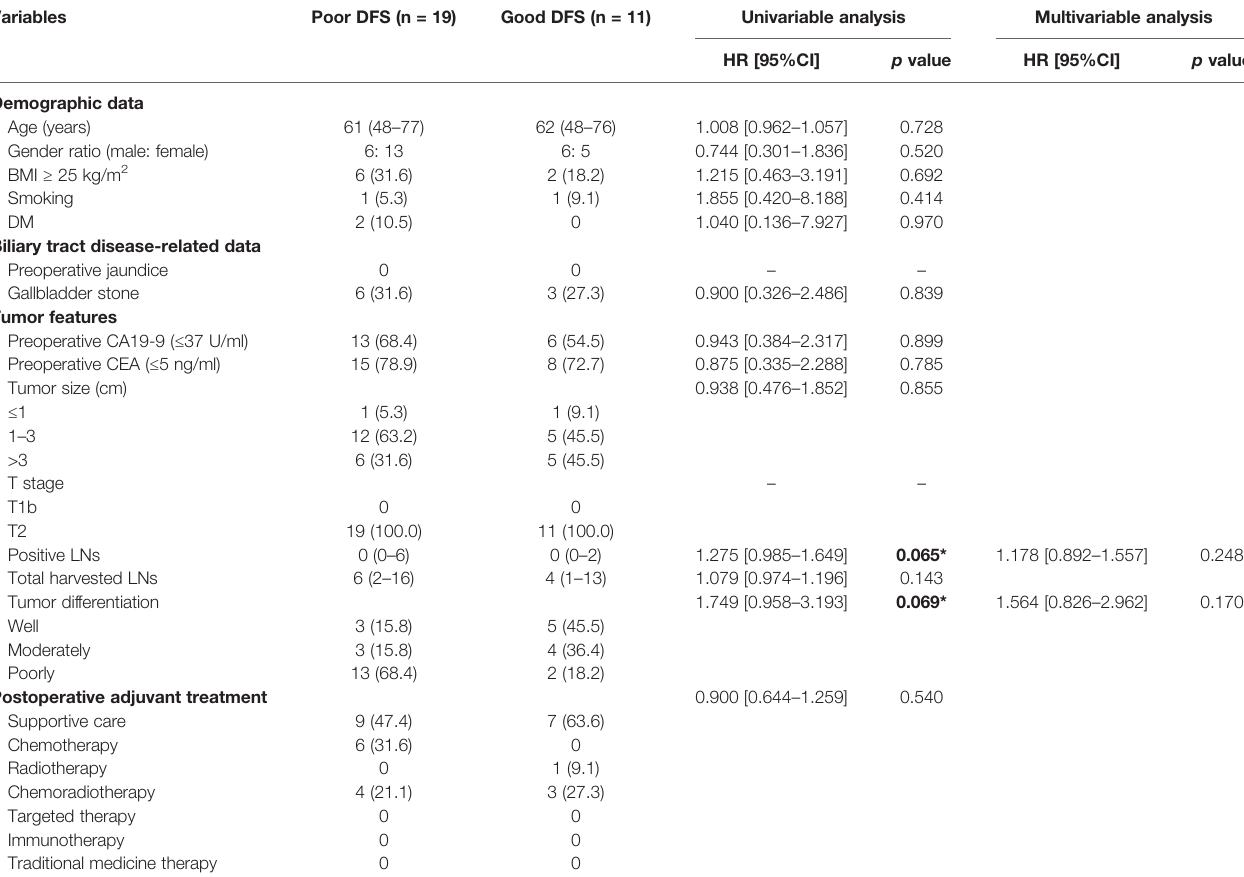
TABLE 3 | Potential risk factors for DFS in GBC patients undergoing PLA based on univariable and multivariable analyses.